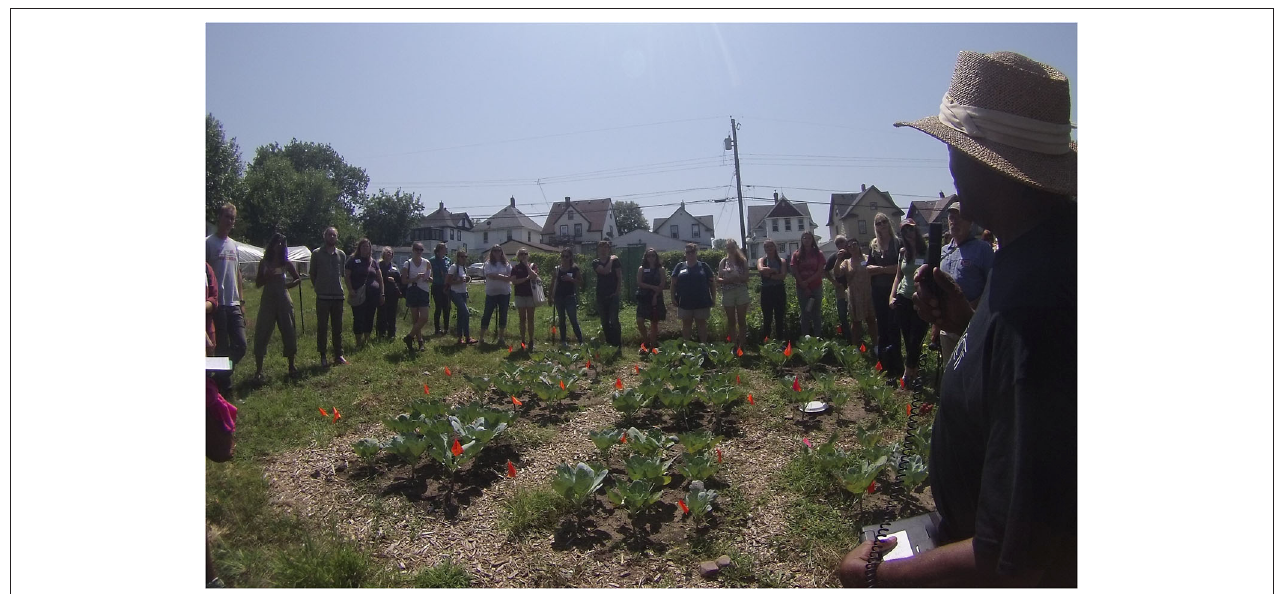
FIGURE 7 | Farm and garden tours as embodied spaces. Joshua (far right) giving a tour of the Coalition’s community garden where we have our study plots to the Urban Food System Symposium attendees in August 2018. Undergraduate students were also there to share about the project and answer questions about the plots (from the far left—Karl, Tulsi, and Matt). Embodied learning allowed attendees to physically experience the space of a garden, see how the history of this neighborhood is physically inscribed on the area, and feel the interactions between collaborating groups. Doing so through the ritual/ceremony of a farm tour—so ubiquitous for those working in agriculture—makes these embodied learning experiences legible across different roles, since this circle included urban and rural extension educators, students, researchers, and activists from across the country.